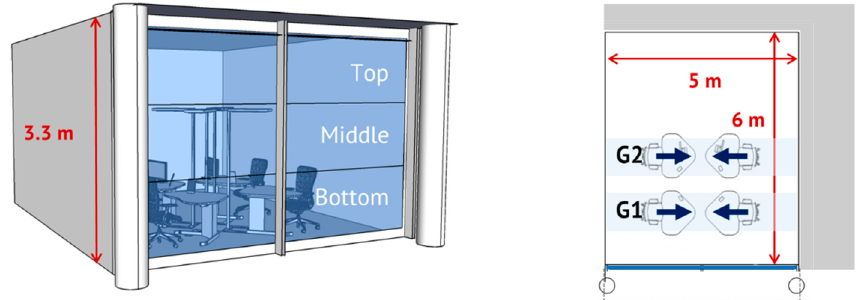
Figure 2. ( Left ) Three-dimensional model of the reference room with different window zones (top, middle, bottom). ( Right ) Plan layout of four occupants’ positions in the open office and groups 1 (G1) and 2 (G2).